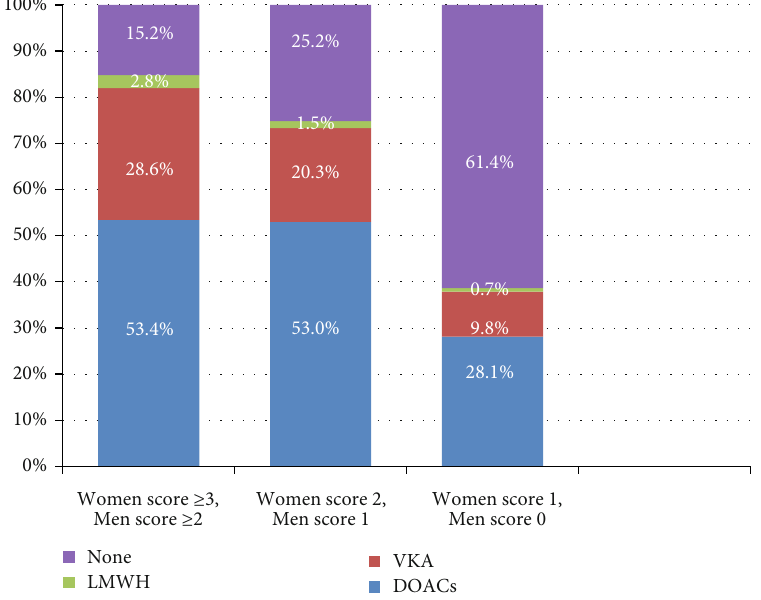
DS -VASc score. DOACs: direct oral 2 2